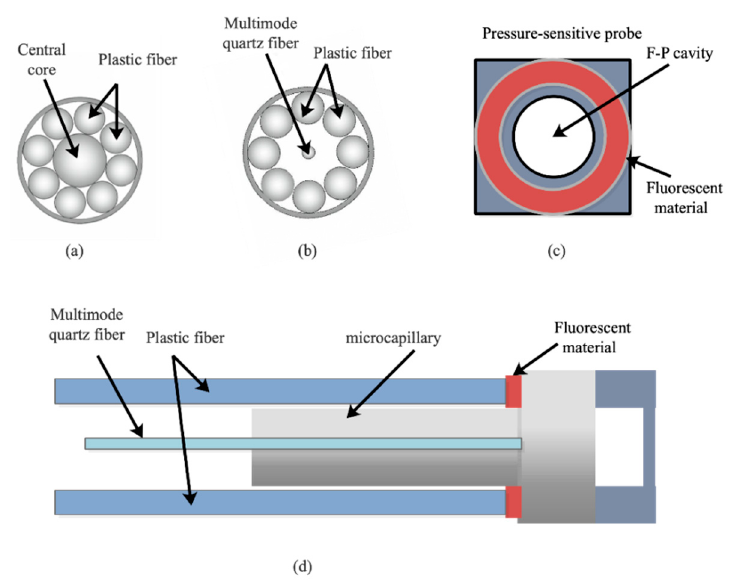
Figure 5. Manufacturing process of hybrid fiber-optic F–P sensor. ( a ) Multi-core plastic fiber, ( b ) replacing the central core, ( c ) mixture coating, ( d ) bonding.